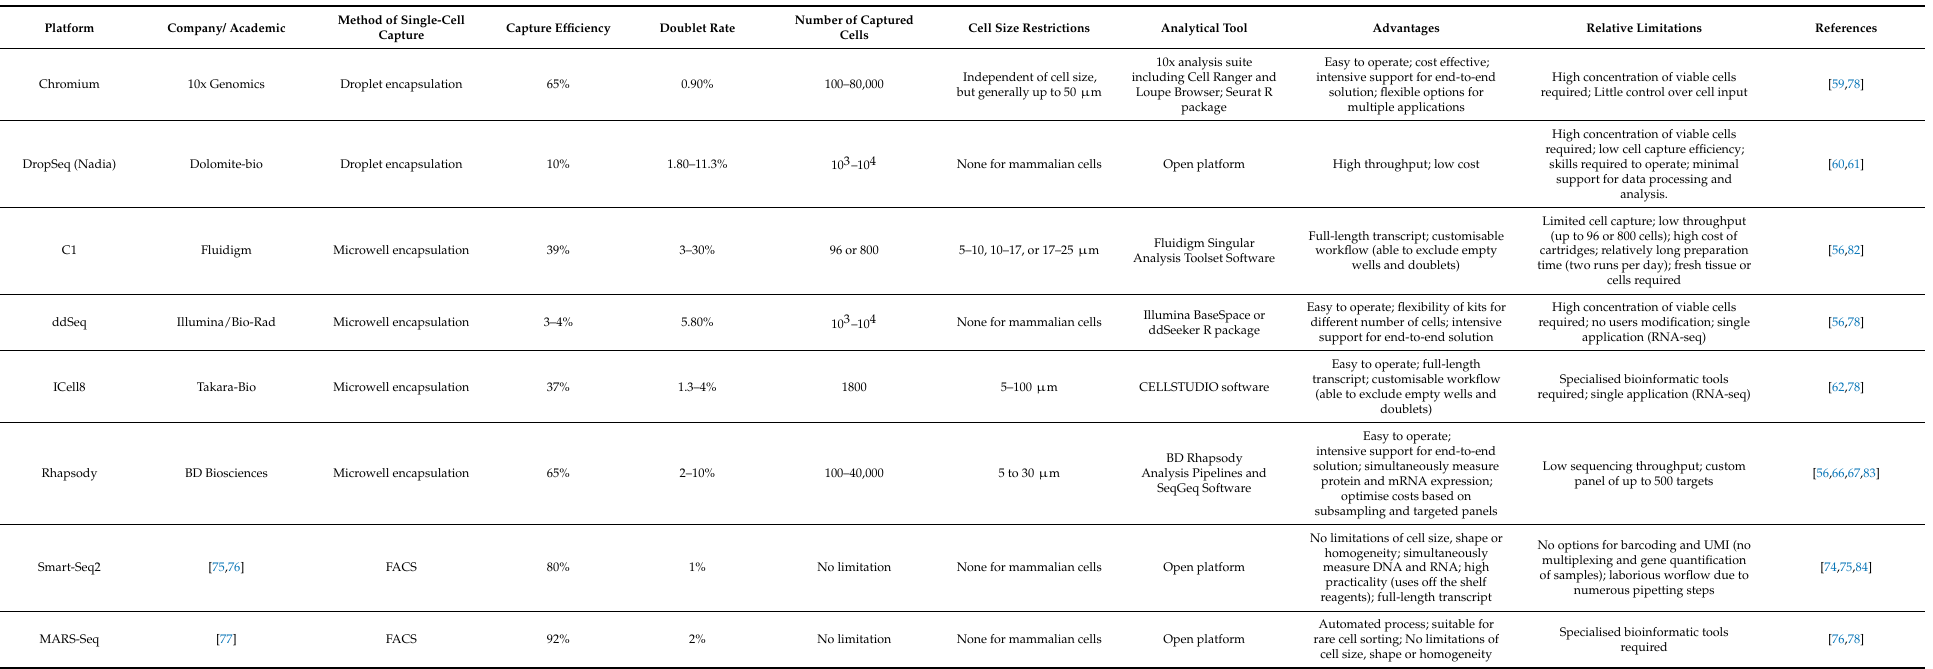
Abbreviation: FACS—fluorescence-activated cell